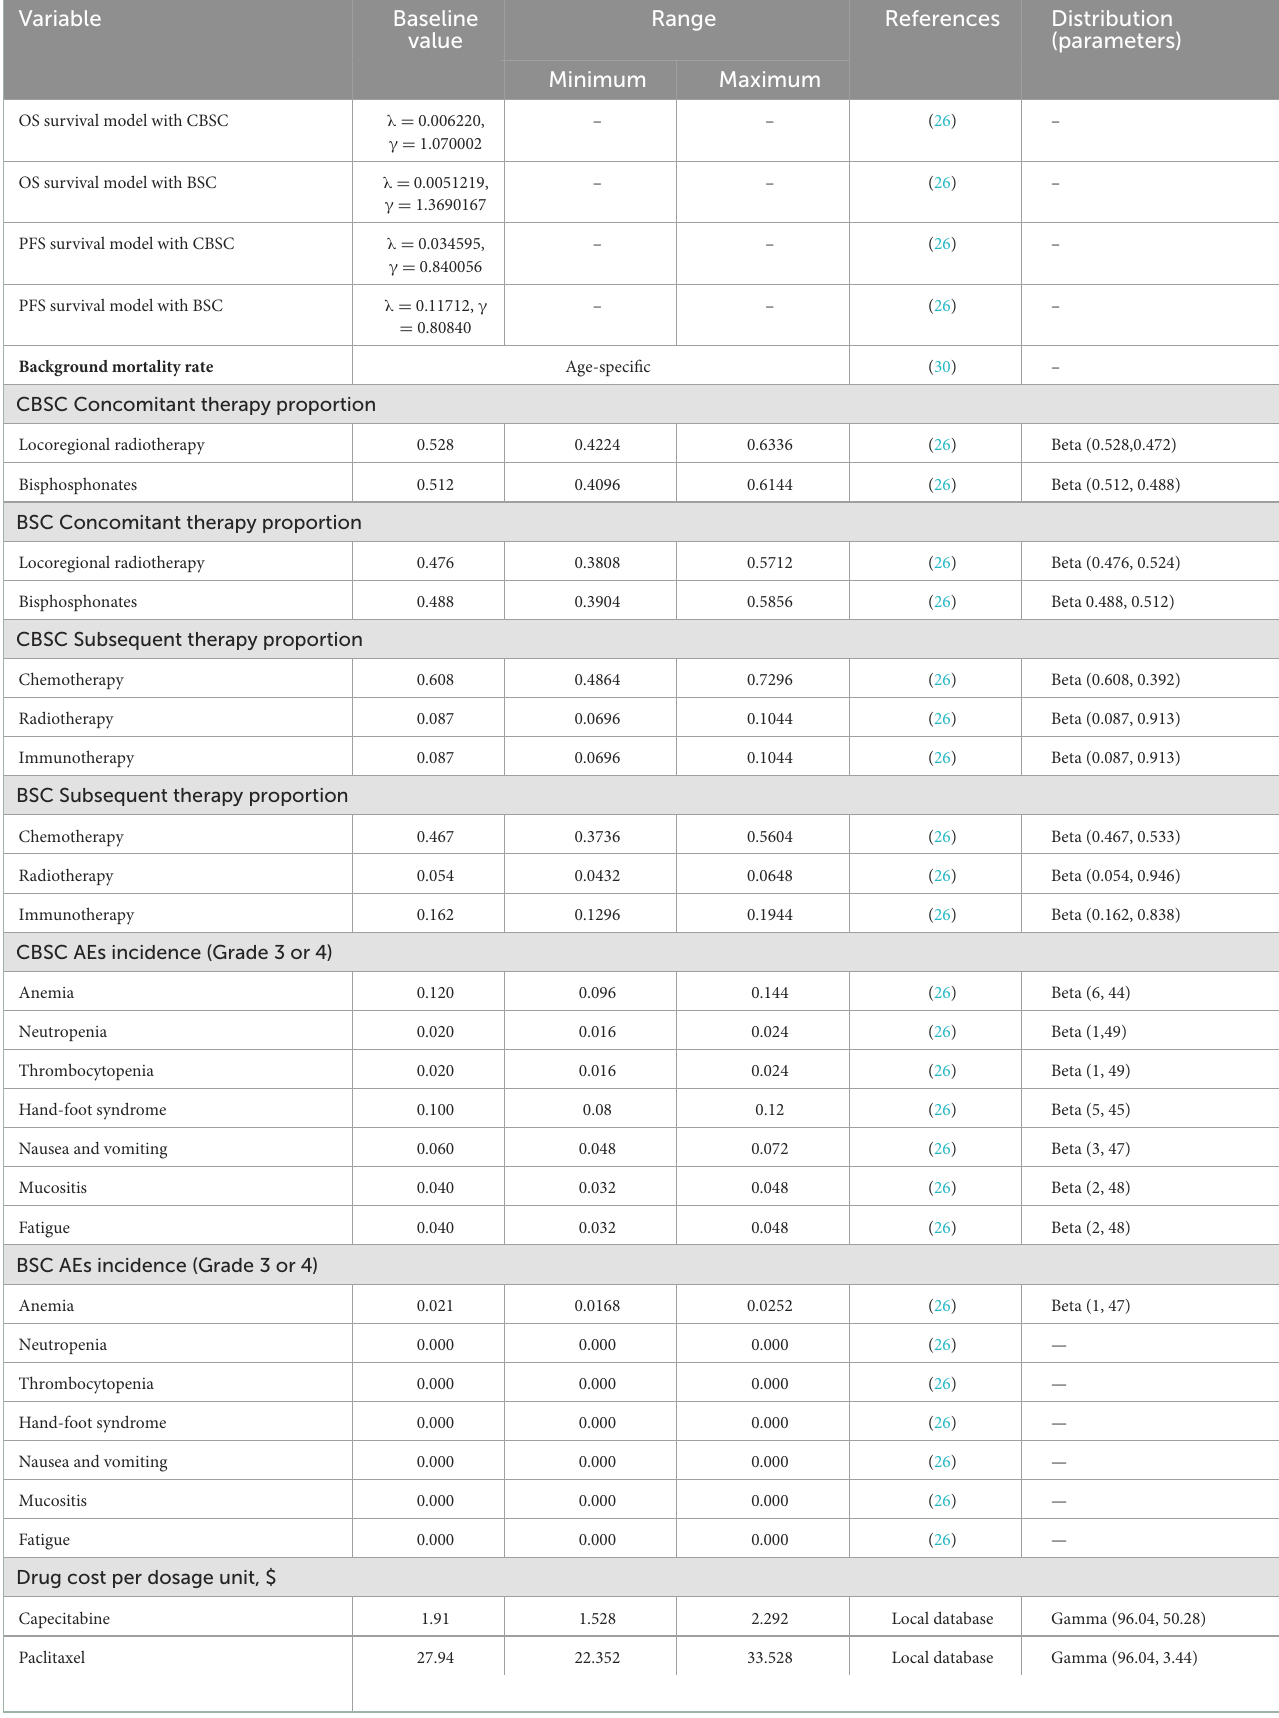
TABLE 1 Model parameters: Baseline values, ranges, and